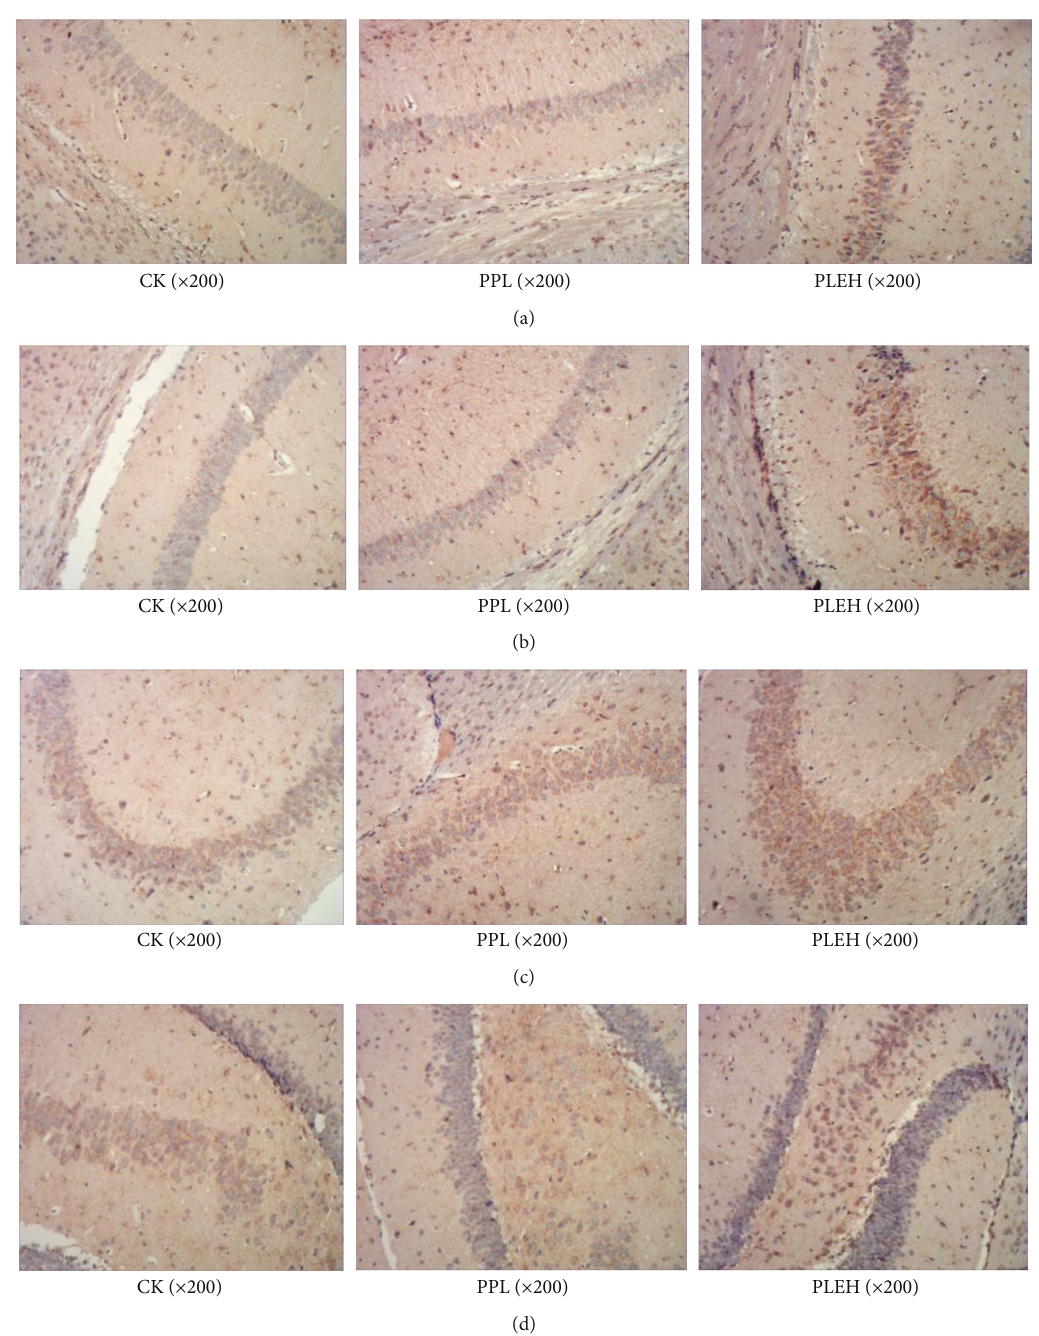
Figure 10: (a) Expressing situation of brain-derived neurotrophic factor (BDNF) in CA1 district of cubs ’ hippocampi. (b) Expressing situation of BDNF in CA2 district of cubs ’ hippocampi. (c) Expressing situation of BDNF in CA3 district of cubs ’ hippocampi. (d) Expressing situation of BDNF in DG district of cubs ’